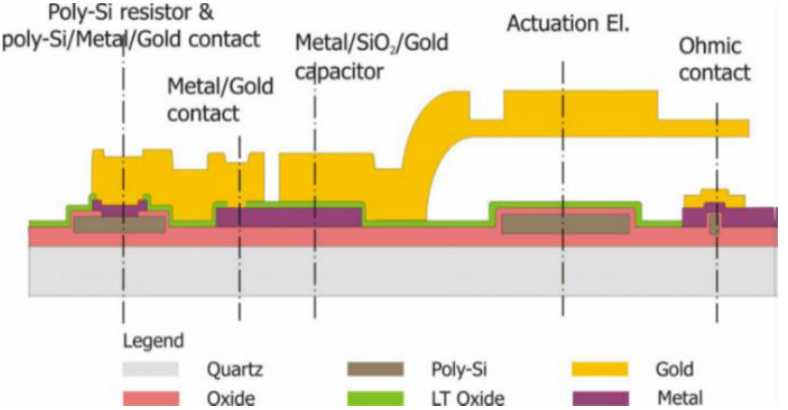
Figure 3. Cross-section view of the FBK-RF-MEMS fabrication process for ohmic-contact